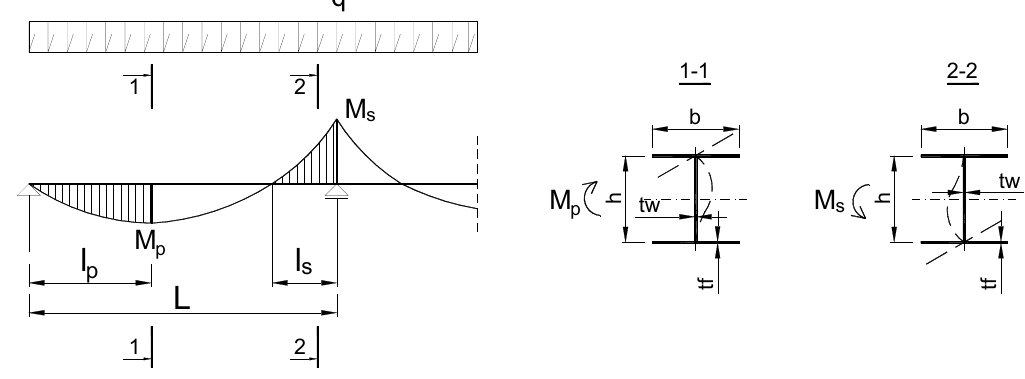
Figure 1. Static model of a continuous beam end span with thin-walled I-section.